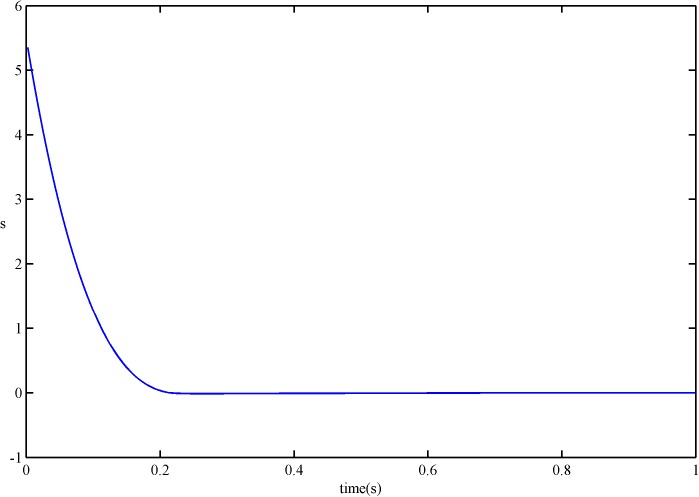
s of SSOSM control.